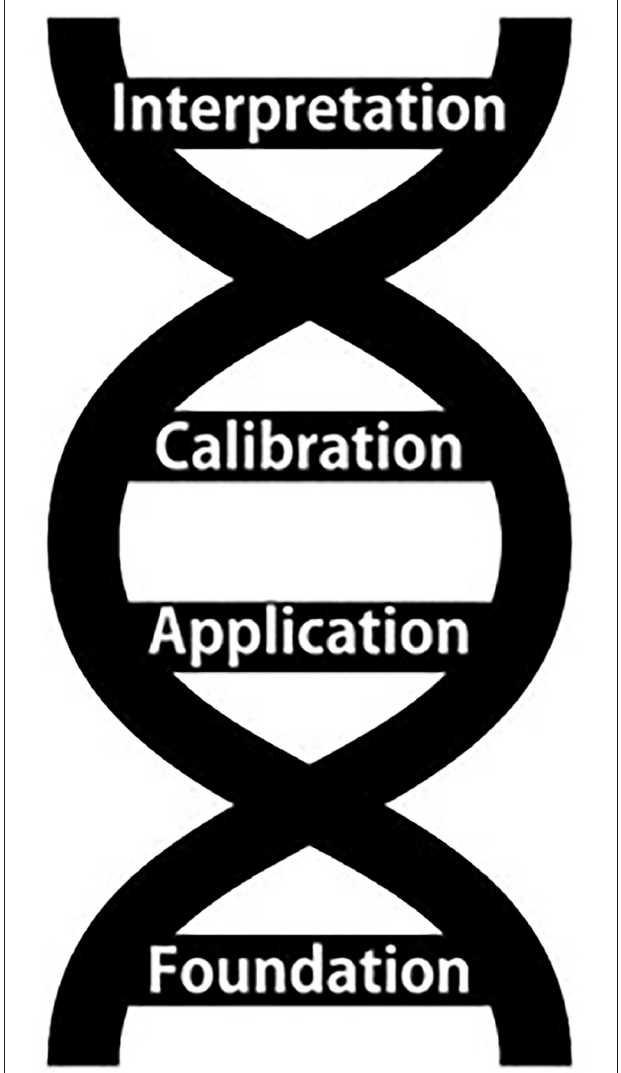
FIGURE 1 | Environmental DNA innovations can be organized into several major “bases” or